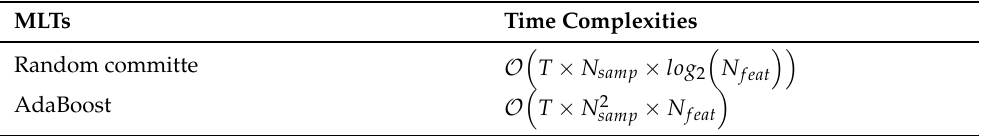
Table 2. Time complexities of random committee using random tree classifier and AdaBoost using J48